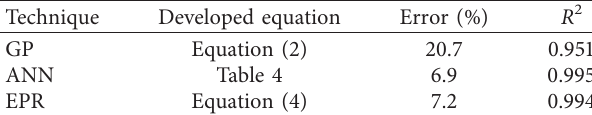
Table 5: Accuracies of the developed models for N ′ c . Technique Table 4